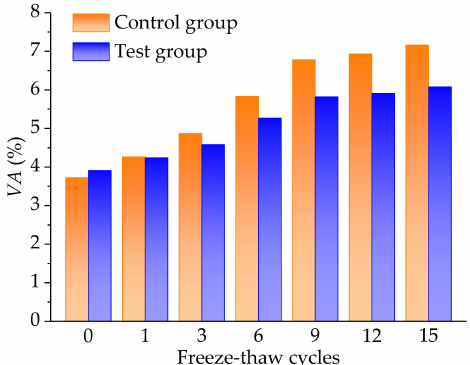
Figure 11. Comparative results of air voids of the control and the test groups, under different freeze-thaw